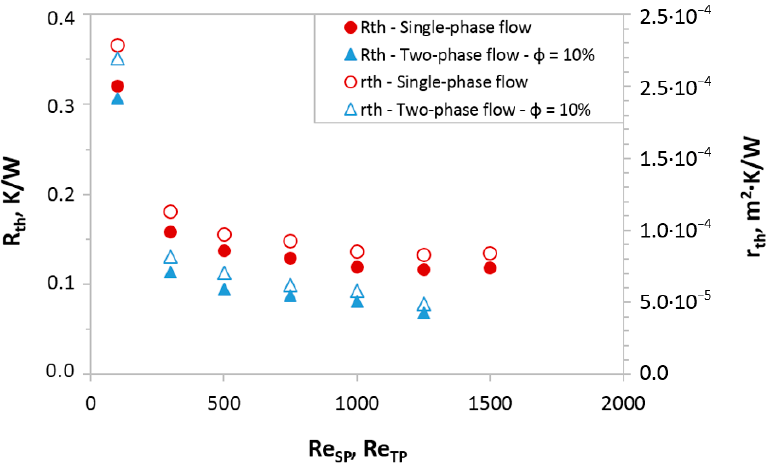
Figure 9. Dependence of the thermal resistance on the Reynolds number.